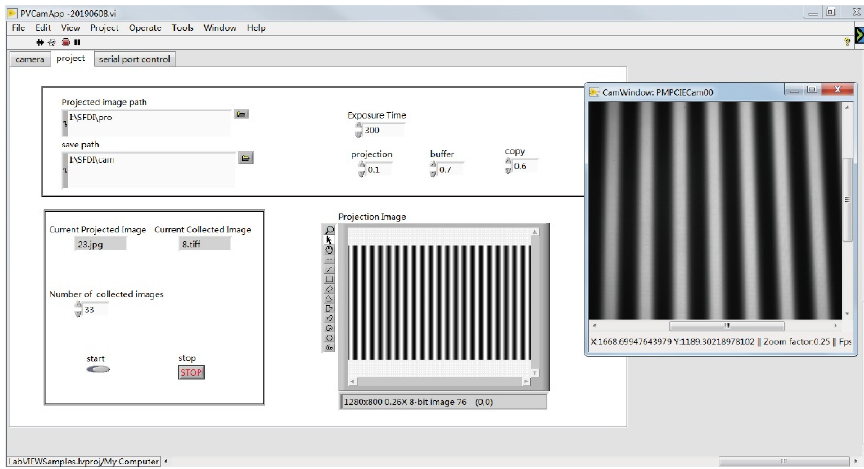
Figure 2. Software for data acquisition and system control developed on the LabVIEW platform.